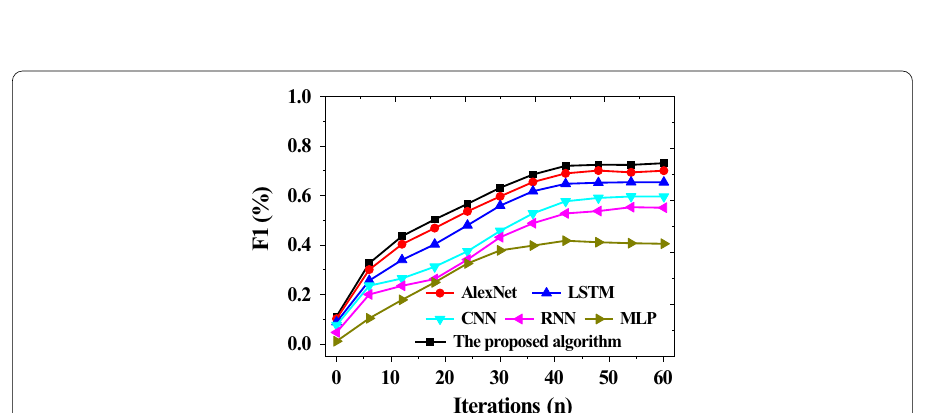
Fig. 8 F1 value curves of different algorithms with the increase of iteration times